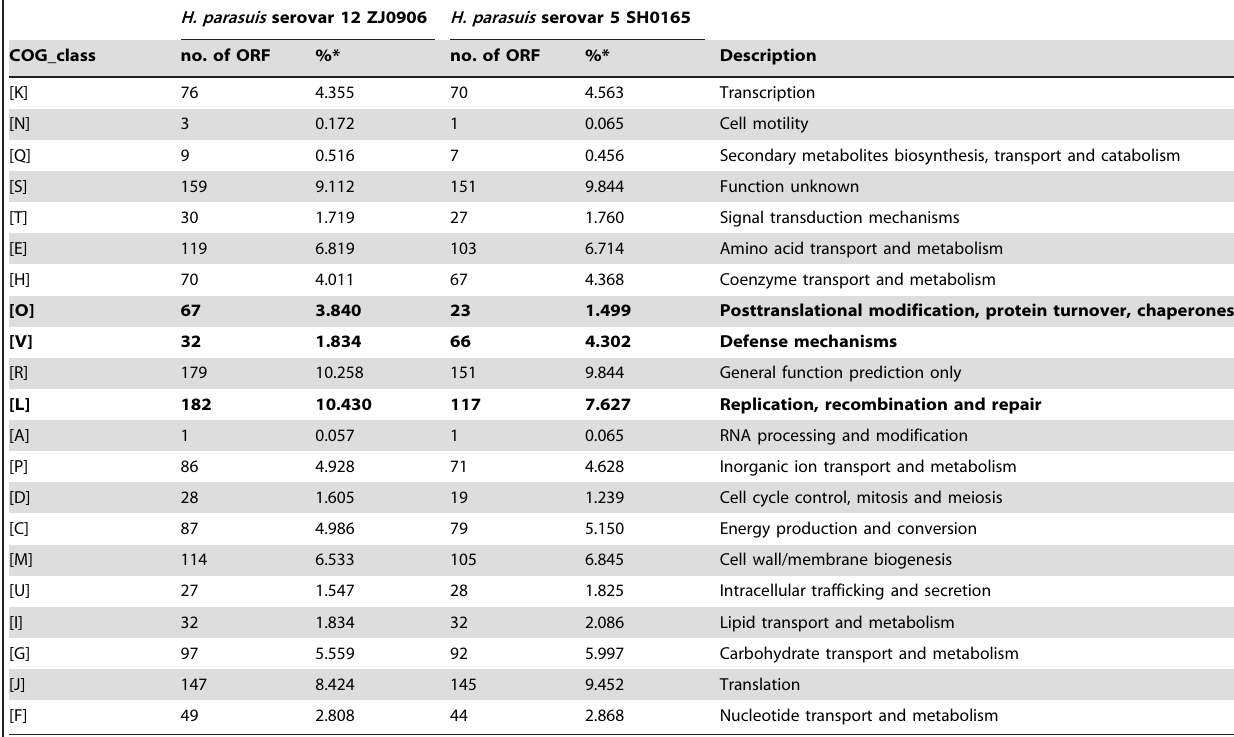
Table 3. Comparison of COG-annotated genes between H. parasuis strains ZJ0906 and SH0165.